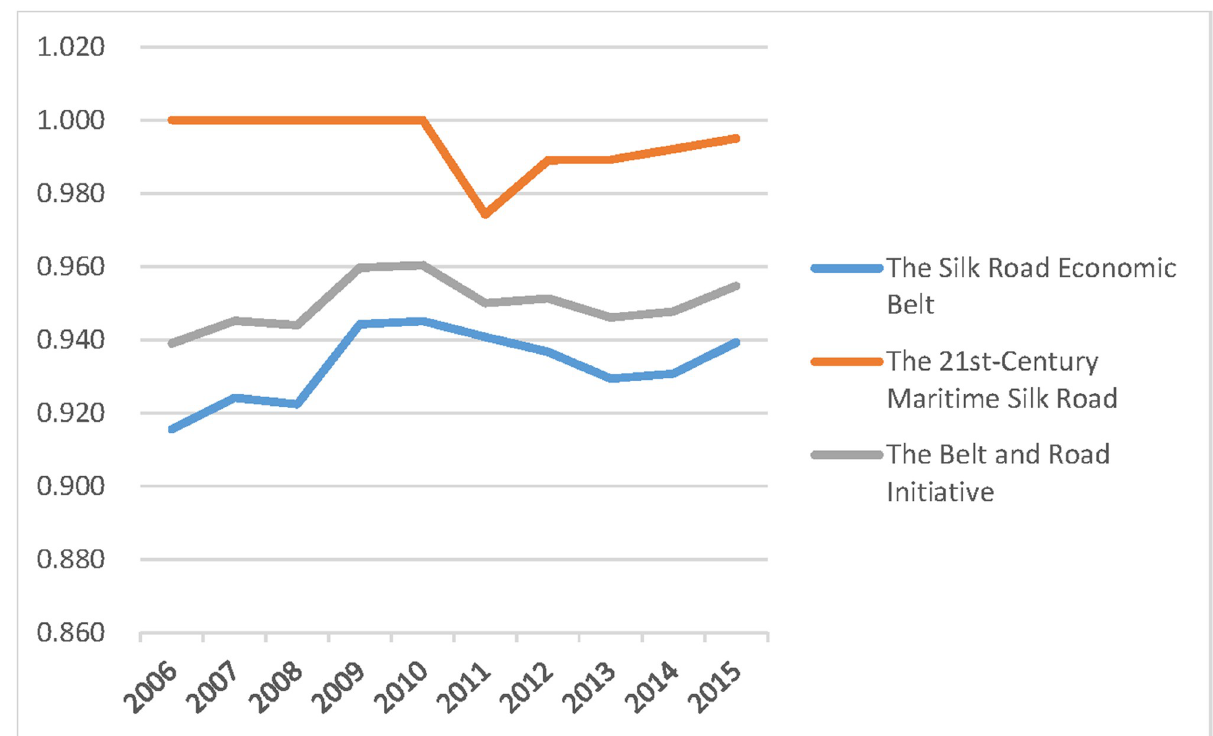
Fig 3. Scale efficiency of different regions, 2006–2015.